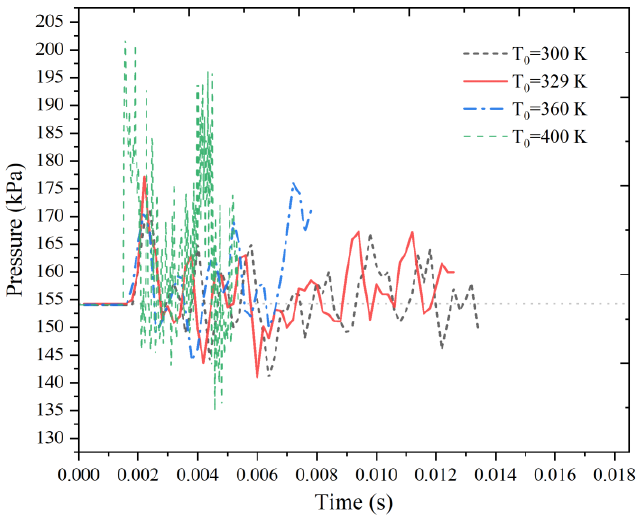
Figure 11. Results of the density gradient distribution under an initial temperature of 400 K.